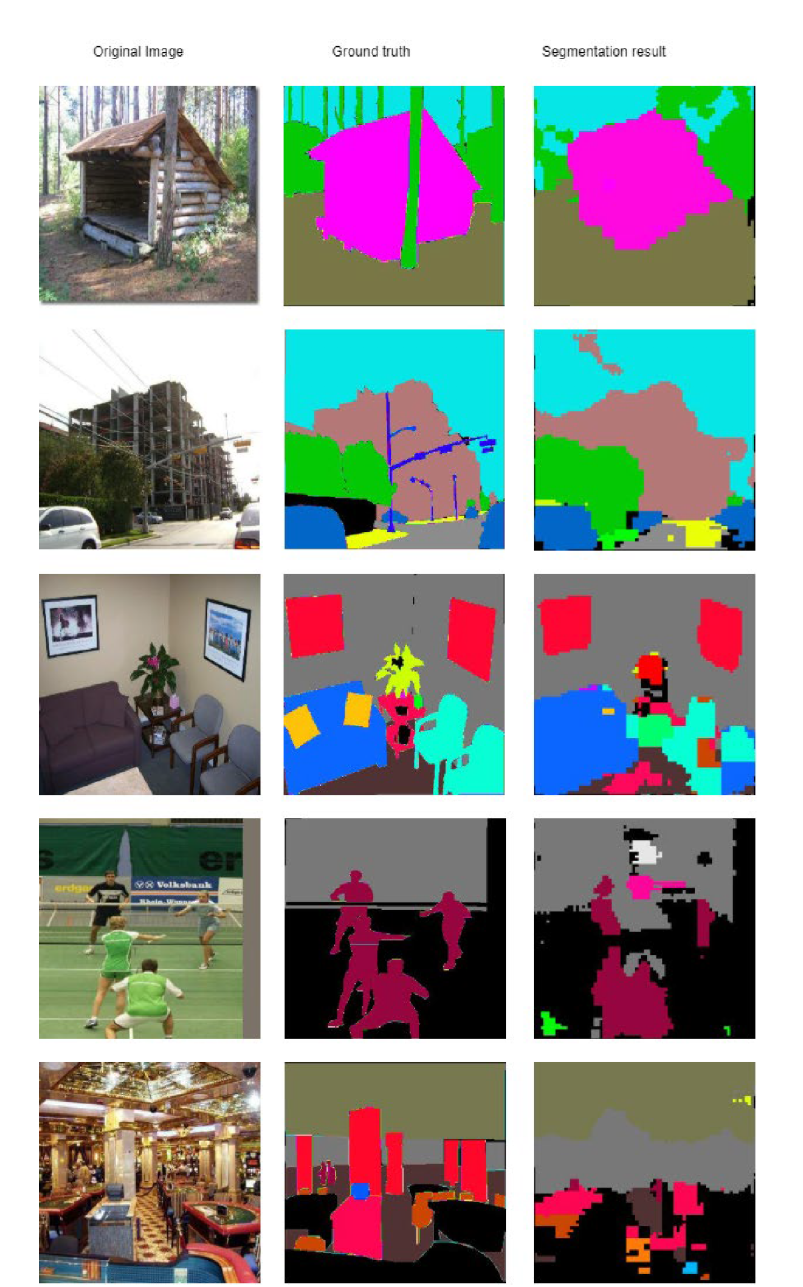
Figure 7. Segmentation result on classes on the ADE20K dataset